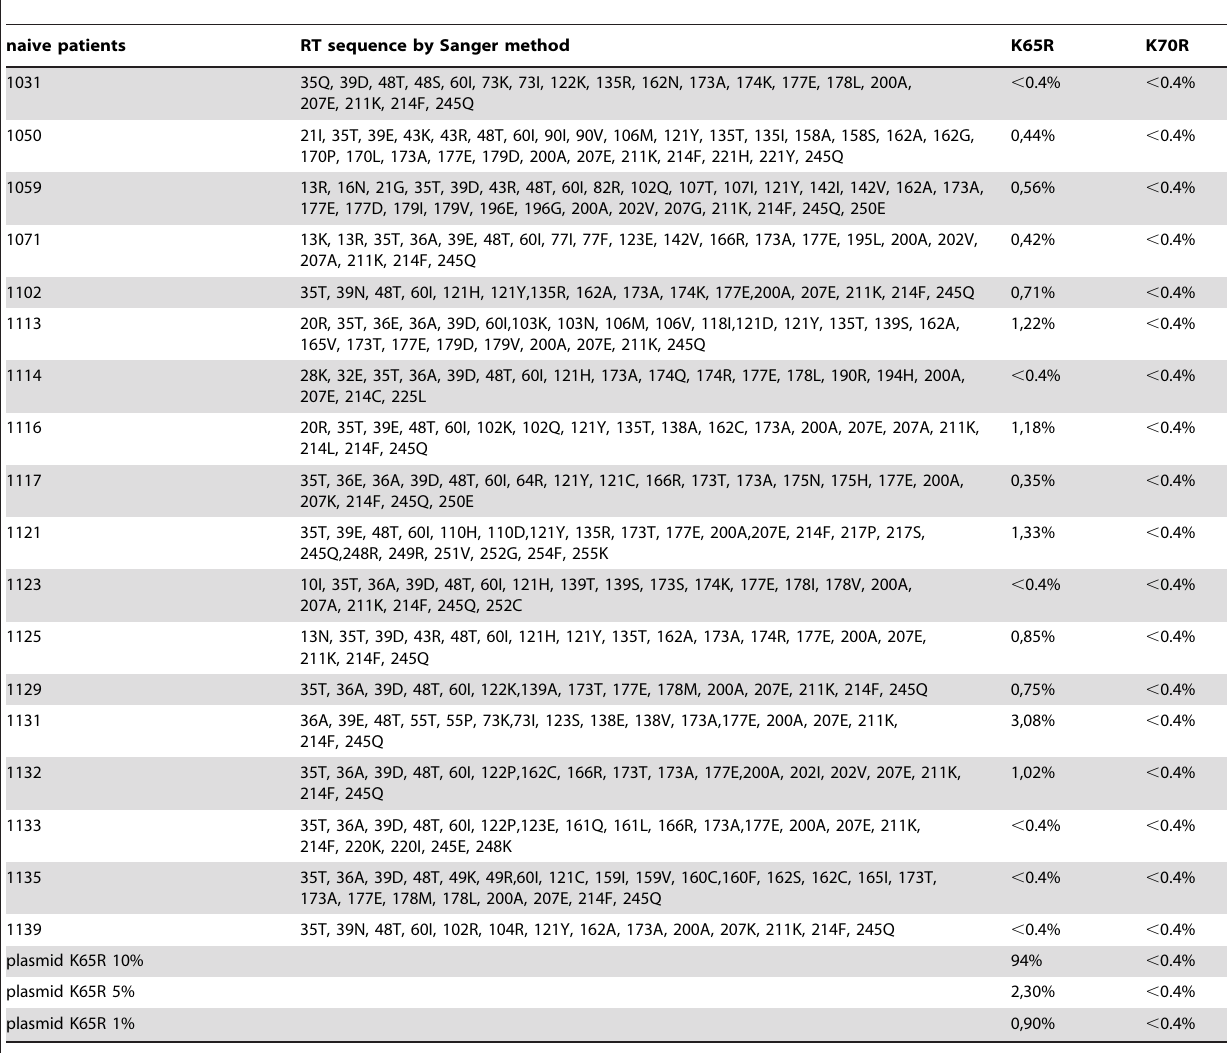
Table 2. RT polymorphic substitutions (Sanger) compared to reference HIV-1 B in isolates from naı¨ve patients and amounts of K65R and K70R mutations in the same isolates plus control